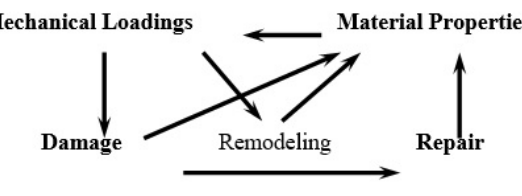
Fig. 1 Bone damage repair